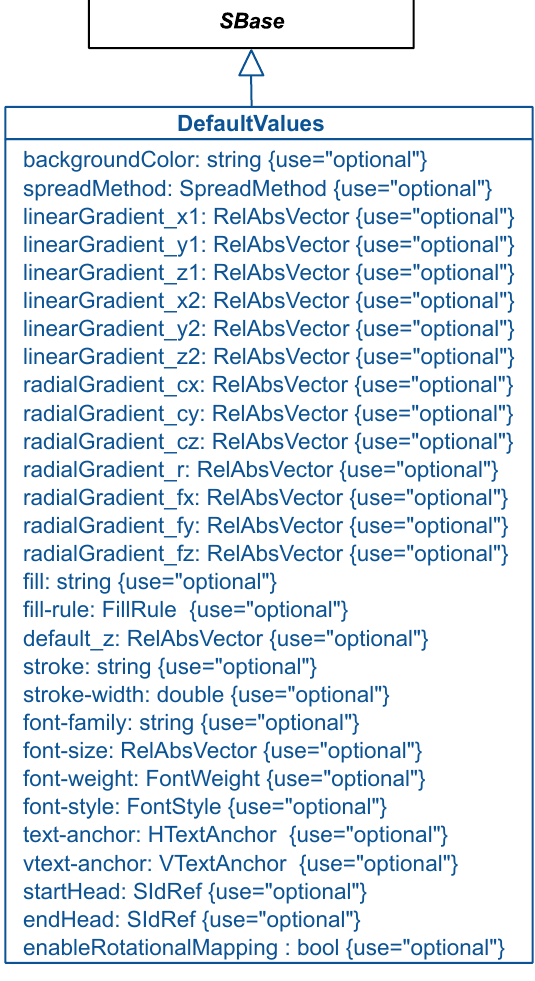
Figure 4: A UML representation of the DefaultValues class for the Render package. See Section 1.4 for conventions related to this